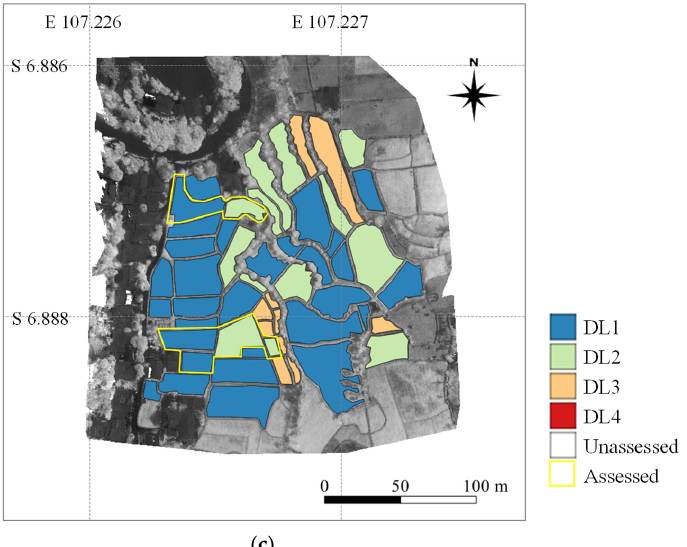
Figure 7. Assessment by a PO and classification results of the two methods in Sukajaya: ( a ) assessed fields by a PO; ( b ) an assessment result by method1; ( c ) an assessment result by method2. Different polygon colors indicate different assessed/classified DLs.